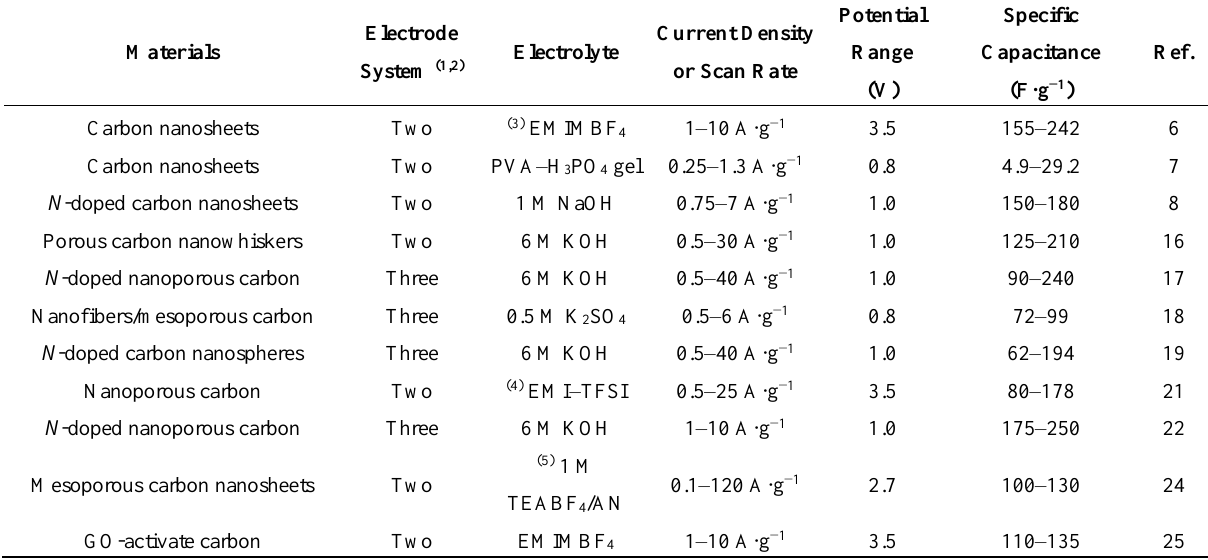
Table 1. EDLC materials and electrochemical